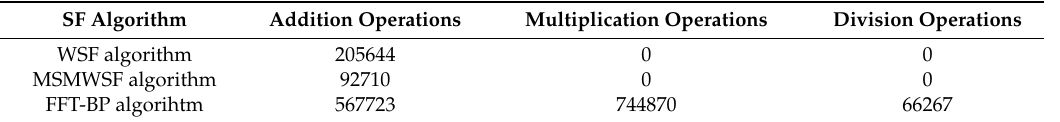
Table 3. Under the condition of Code 2, Eb/N0 = 4.5 dB, decoding complexity of three algorithms.